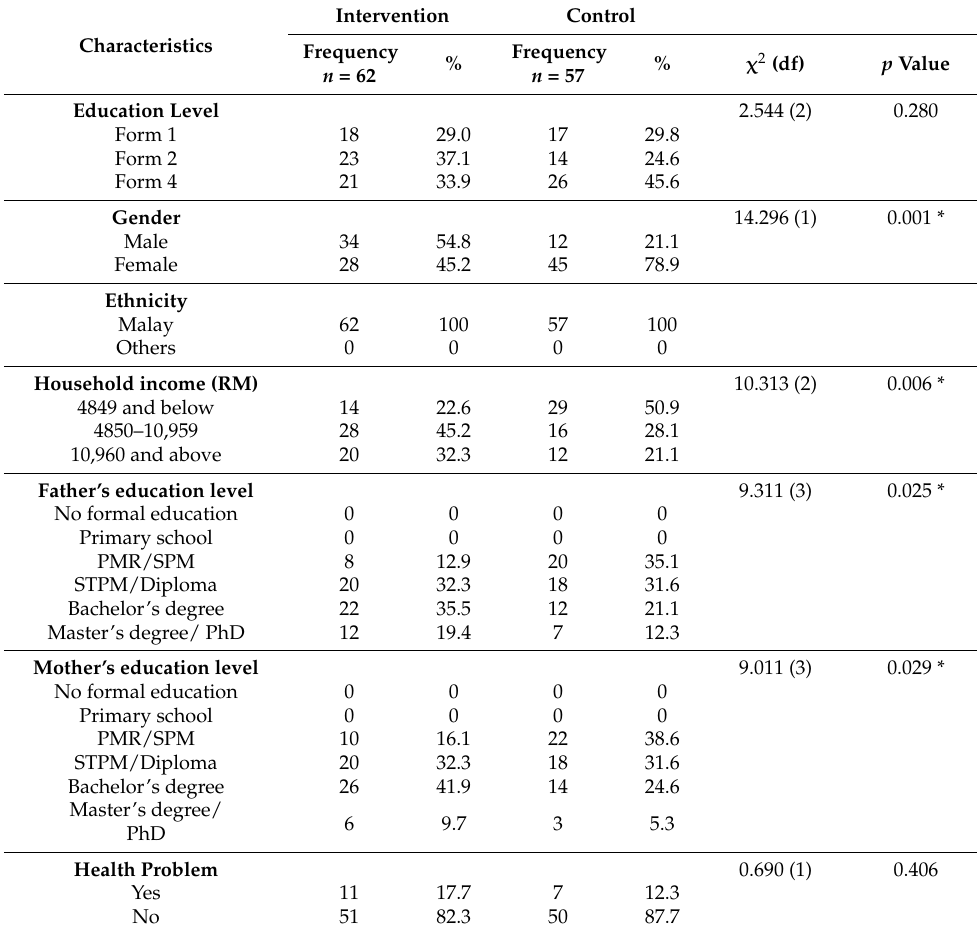
Table 1. Baseline sociodemographic characteristics.